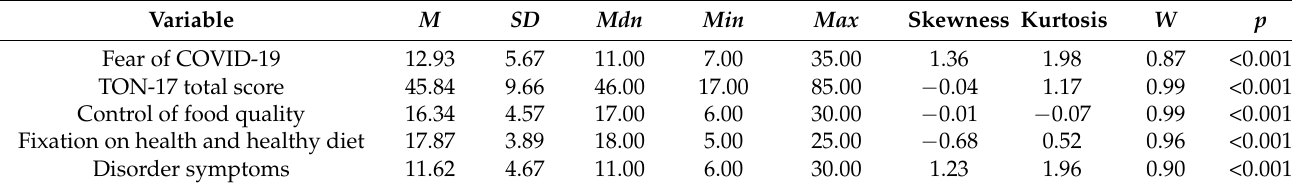
Table 2. Descriptive statistics, normality tests, and reliability coefficients of measured